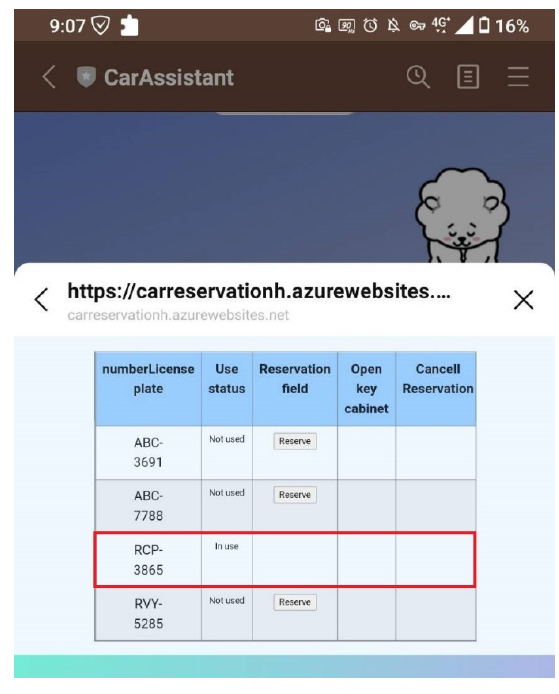
Figure 33. Line app reservation page.